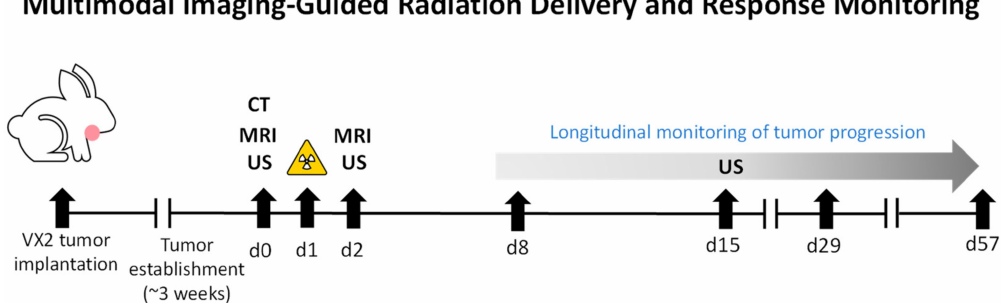
Figure 1. Multimodal imaging-guided radiation delivery and response monitoring. Schematic shows the study design and sequence of imaging examinations conducted in VX2 tumor bearing rabbits. Combined magnetic resonance imaging (MRI) and computed tomography (CT) were used for radiation treatment planning while ultrasound (US) was used to assess changes in tumor growth. Radiation therapy (indicated by the yellow symbol) was delivered 24 h following baseline line image